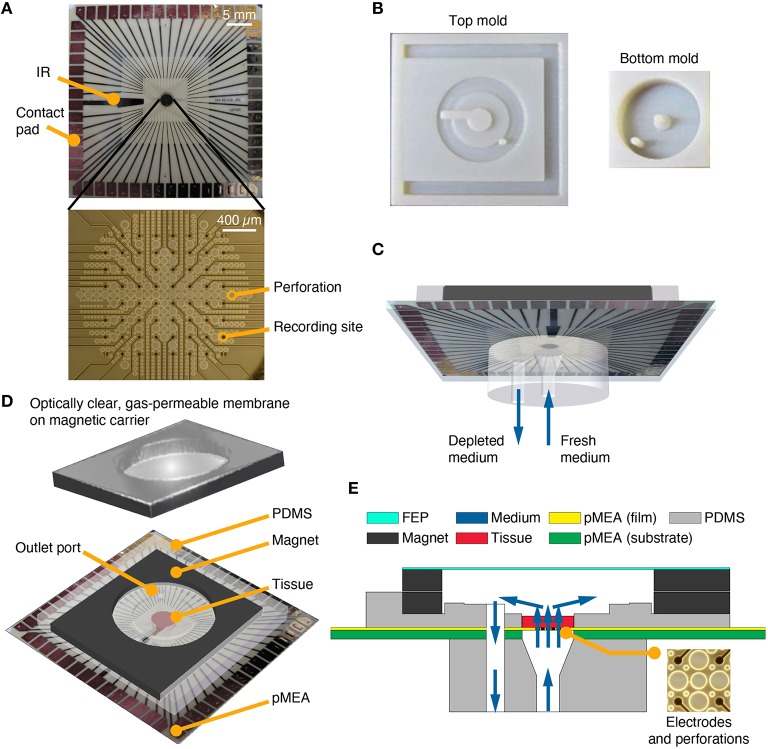
PDMS-pMEA sandwich design. (A) pMEA as supplied by the manufacturer, Multi Channel Systems MCS GmbH. The pMEAs have recording sites and perforations, which were used to deliver fresh medium to the tissue culture seated and adhered to the pMEA. The pMEAs have 60 electrodes [59 recording, 1 internal reference (IR)] which were used to electrically record from and stimulate the cultures. (B) Plastic molds for the top and bottom pieces of the PDMS-pMEA sandwich. (C) The bottom PDMS piece of the PDMS-pMEA sandwich comprising an inlet port to force fresh medium through the tissue and an outlet port to withdraw depleted medium. (D) The top PDMS piece of the PDMS-pMEA sandwich comprising perfused culture chamber, a co-axial outer chamber for perfusate withdrawal, and the magnet for attaching the lid. The tissue was seated in the culture chamber directly over the electrode array. (E) Vertical cross-section view of the device showing key design components. Medium, depicted by blue arrows, was delivered through the inlet port. It passed through the pMEA perforations and through the tissue in the culture chamber, before it was withdrawn through the outlet port.